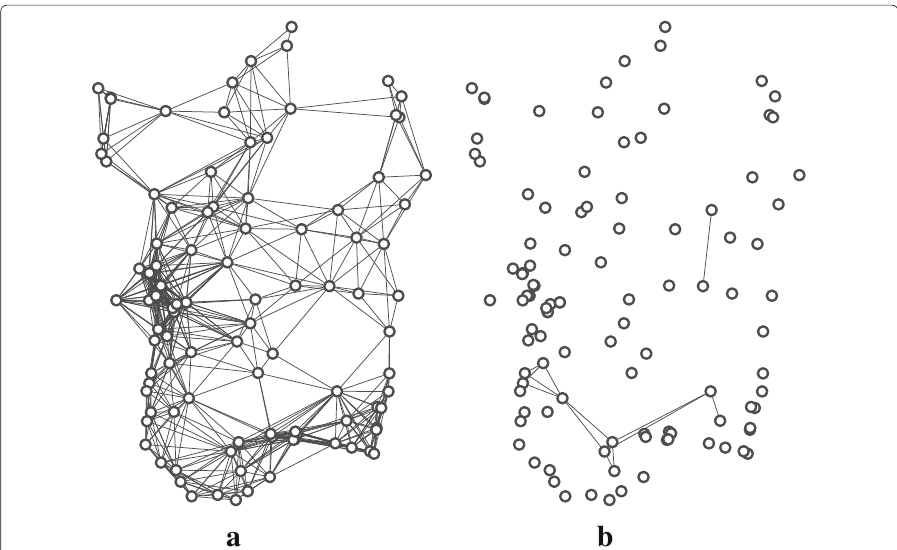
Fig. 1 Graph models of Natura 2000 sites in Sardinia. a Raw-distance graph. Edges link pairs of nodes with a geographical distance up to 30 Km between boundaries. The position of each node roughly corresponds to the coordinates of the site centroid. b Full single-species graph for Cervuselaphuscorsicanus (species code 1367). Edges correspond to a subset of the edges in the raw-distance graph; each edge links pairs of nodes with the target species reported to be present in